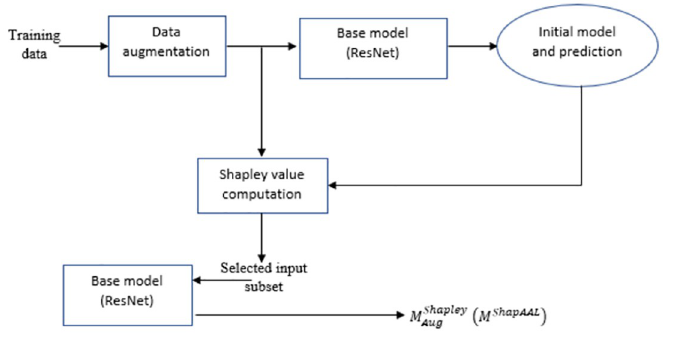
Fig 14. Constructing the proposed model M ShapAAL .